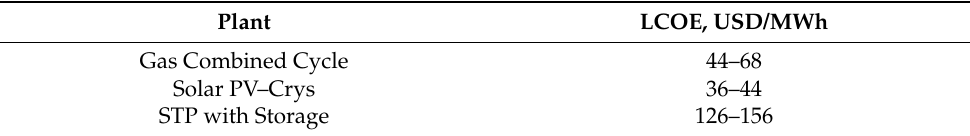
Table 13. LCOE reference for the technologies studied